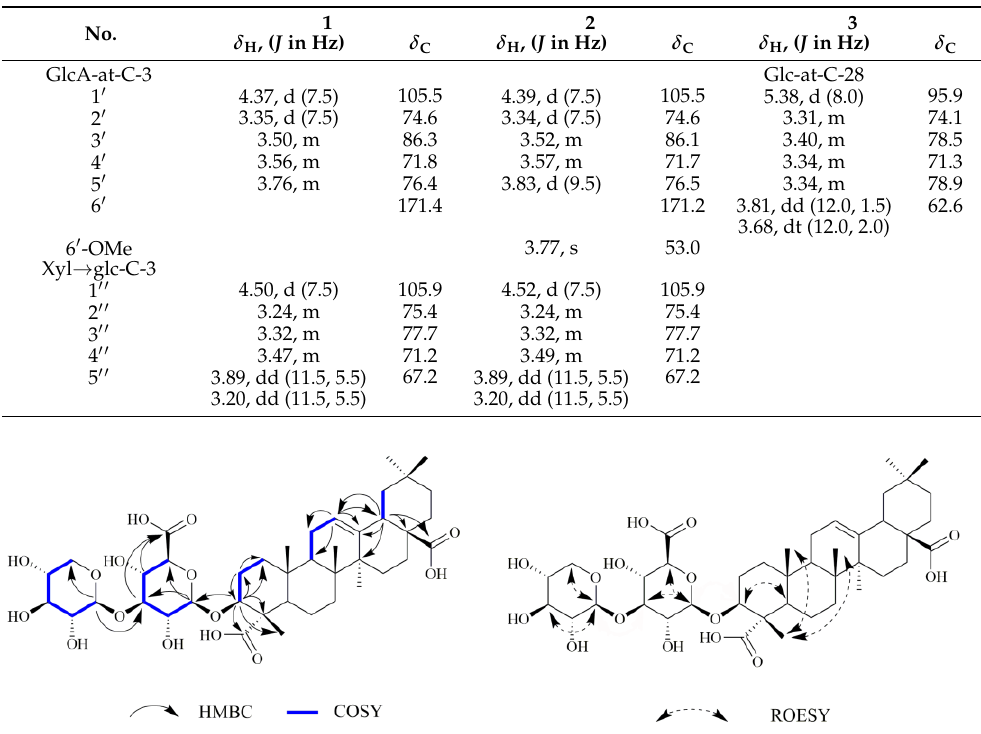
Figure 1. Key HMBC, COSY, and ROESY correlations of compound 1 . Table 1. 1 H NMR (500 MHz) and 13 C NMR (125 MHz) data of compounds 1 – 3 in methanol- d 4 .